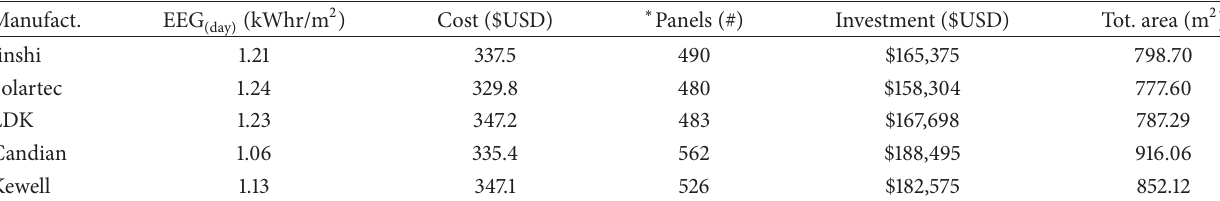
Table 6: Investment and total area required for JAPAY project at